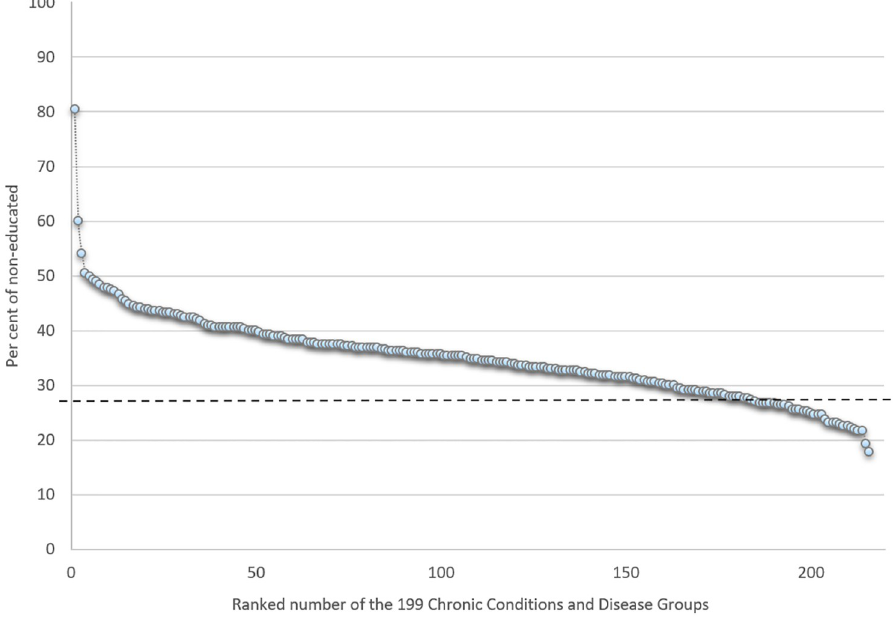
Fig 1. Per cent of people with no education within the 199 chronic conditions and disease groups ranked by descending proportion. The dashed line is the national average of 29.0 per cent.